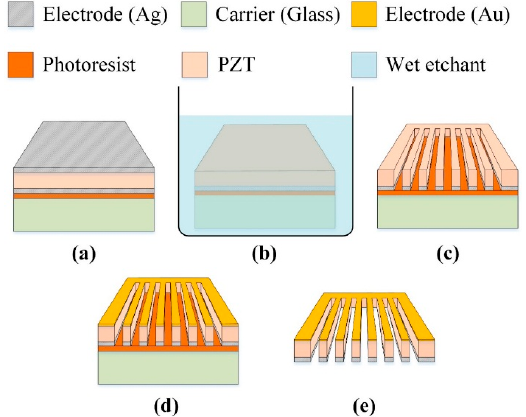
Figure 4. Process flow of the strip PZT pyroelectric cell. ( a ) The PZT cell attached to a glass carrier; ( b ) the top electrode (Ag) etched; ( c ) the PZT cell stripped; ( d ) the top electrode (Au) deposited on the strip PZT pyroelectric cell; ( e ) the carrier removed.